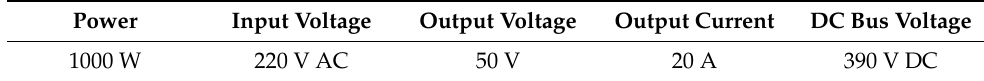
Table 2. The main system parameters of the module.